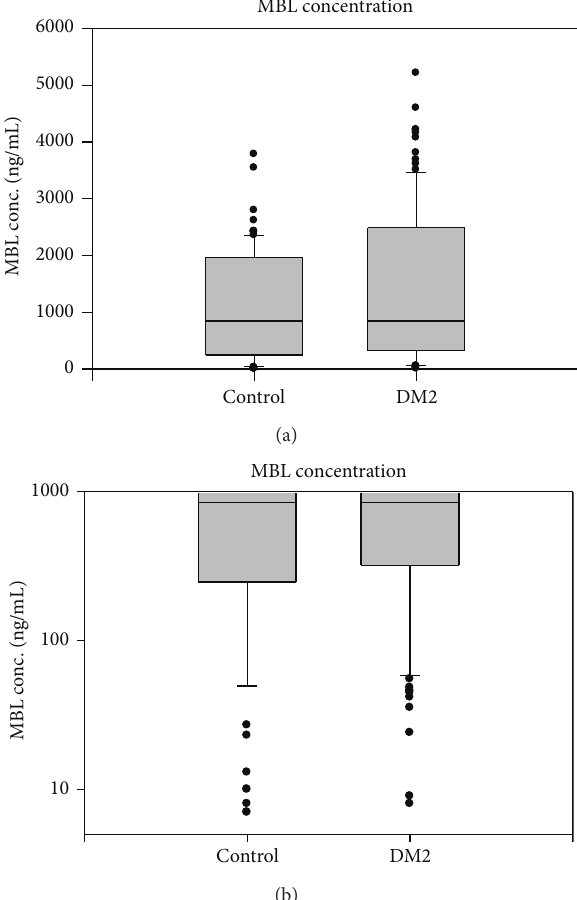
Figure 1: Box and Whisker plots of Mannose-binding lectin (MBL) distribution in type 2 diabetics and controls. The median (lower and upper quartiles) levels for MBL in T2DM and controls were 819 ng/mL (321–1871) and 846 ng/mL (247–1969), respectively. There was no significant difference between either group.